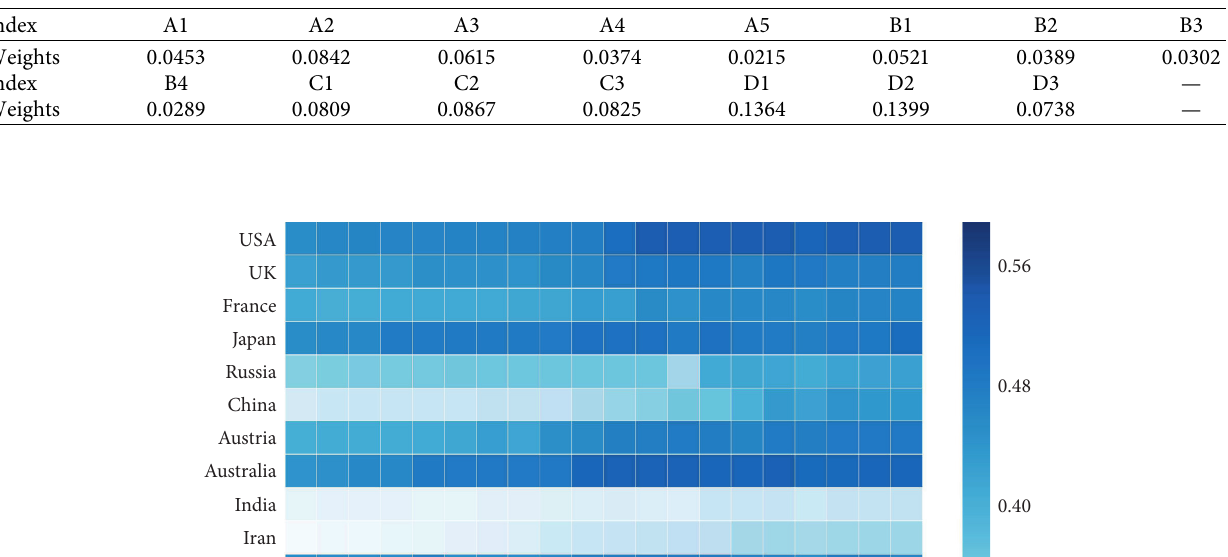
Table 3: The weight of each indicator.